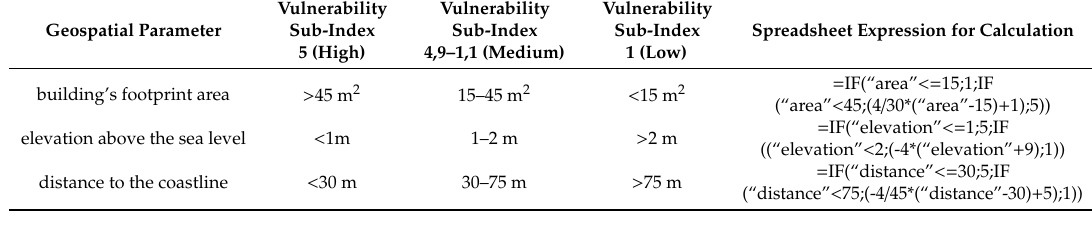
Table 2. Continuous rankings: the vulnerability sub-indices V area , V elevation, and V distance .